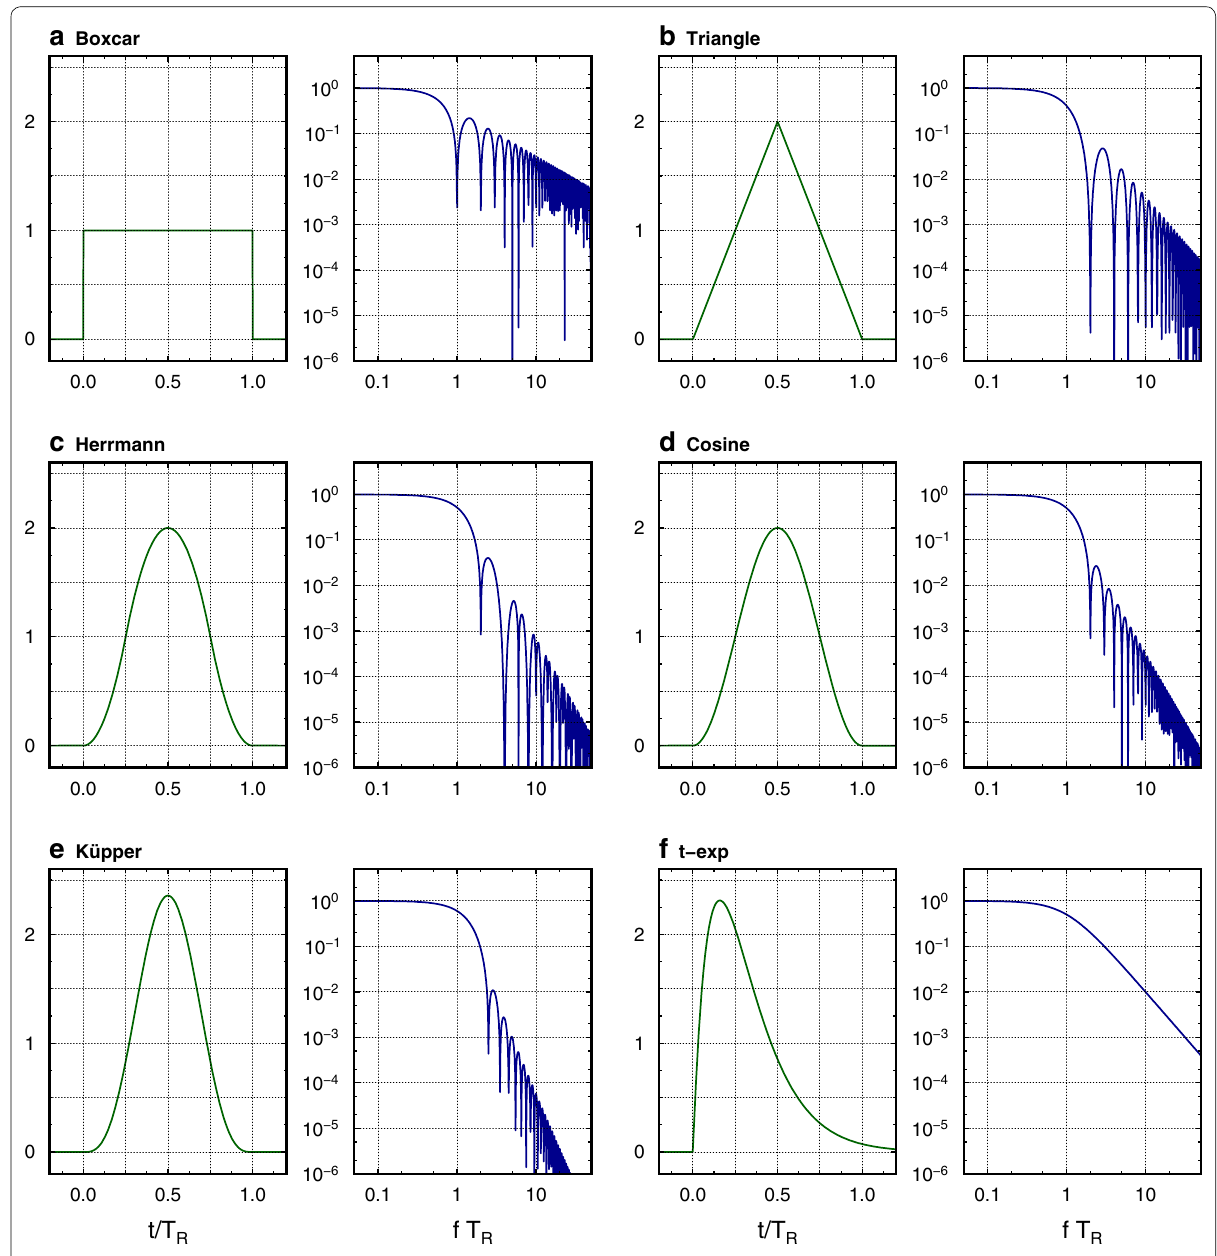
Fig. 4 Implemented source time functions and their amplitude spectra: a boxcar function, b triangle function, c Herrmann function, d cosine func- t tion, e Küpper’s wavelet and f t exp function. In each panel, the left figure shows the temporal variation of the source time function and the right [− ] figure shows the amplitude spectrum. The horizontal axes are normalized by the rise time T